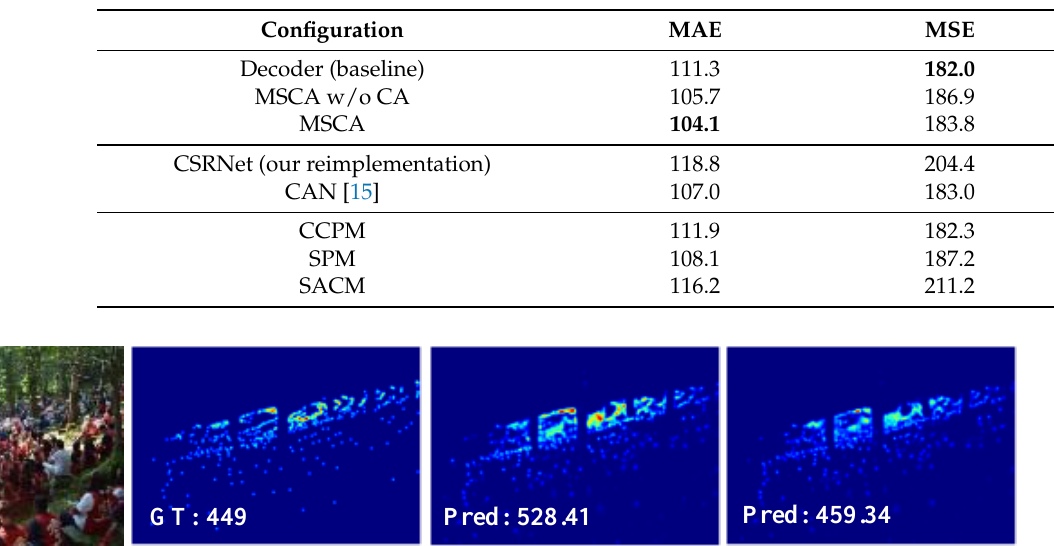
Figure 7. Impacts of CA on UCF-QNRF. From left to right: input image, ground-truth, result of MSCA w/o CA, and result of